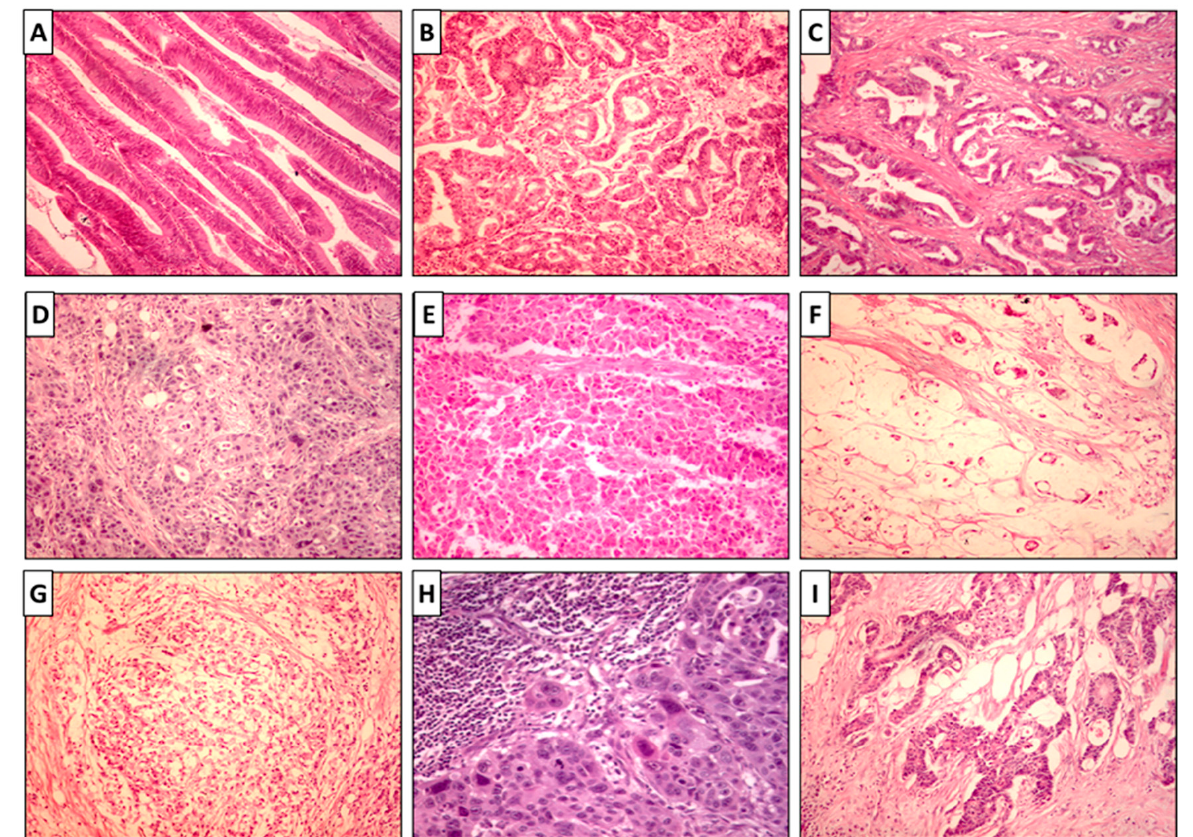
Figure 1. Histopathological findings in colon carcinoma. ( A ) Colonic adenoma with a moderate to high degree of dysplasia (×100). ( B ) Well-differentiated colon adenocarcinoma formed of more than 95% of invasive irregular separate glands (×200). ( C ) Moderately differentiated colonic adenocarci- noma (Grade 2) showing irregular fused glands infiltrating the wall (×200). ( D ) Poorly differentiated colonic adenocarcinoma (Grade 3) showing diffuse sheets of pleomorphic anaplastic cells with few irregular acinar-like structures (×200). ( E ) Poorly differentiated colonic adenocarcinoma (Grade 3) formed of sheets of undifferentiated cells with no evidence of acinar formations (×200). ( F ) Mucinous colonic carcinoma showed lakes and pools with mucin with floating malignant cells and fragments of acini (×200). ( G ) Signet ring carcinoma of the colon formed of malignant cells with signet ring appearance (×200). ( H ) Mesenteric lymph node containing metastatic deposits of colonic carcinoma (×200). ( I ) Deep invasion of colonic carcinoma in the colonic wall down to subserosal fat (×100).